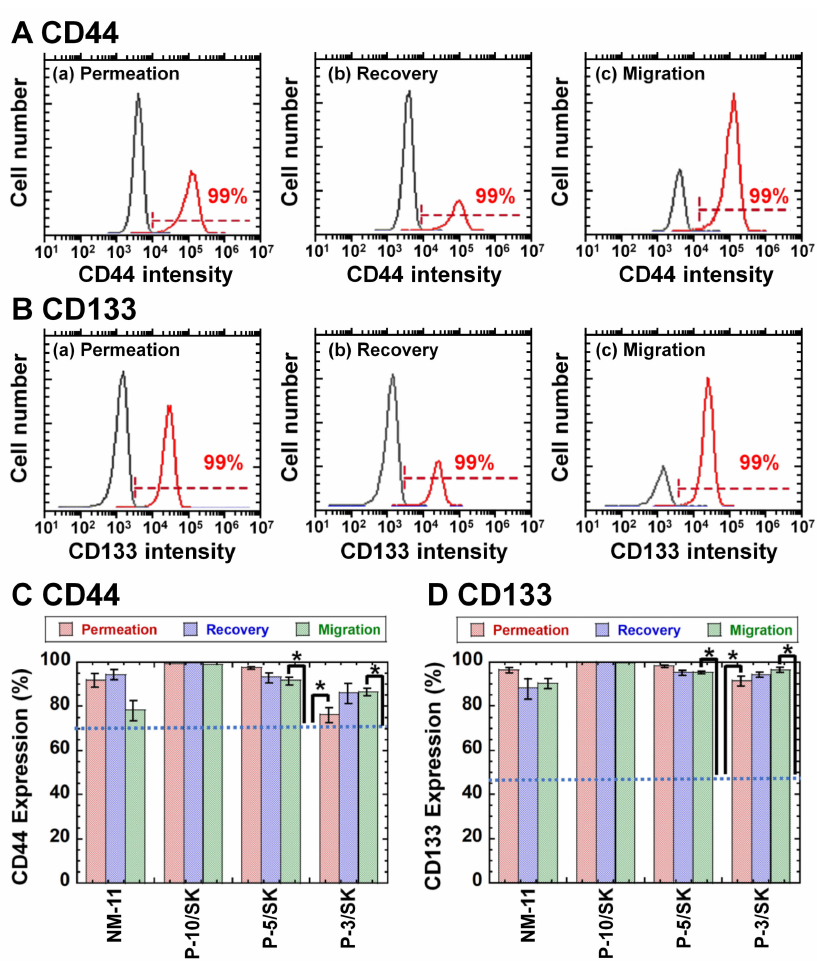
Figure 4. CD44 and CD 133 (CSC marker) expression in colon carcinoma HT-29 cells after filtration via NM-11 and PLGA/SK filters. ( A ) Flow cytometry chart of CD44 expression on HT-29 cells in the permeation solution ( a ), recovered solution ( b ), and migrated cells ( c ) via PLGA-10/SK filters. ( B ) Flow cytometry chart of CD133 expression on HT-29 cells in permeation solution ( a ), recovered solution ( b ), and migrated cells ( c ) via PLGA-10/SK filters. ( C ) CD44 expression on colon carcinoma HT-29 cells in the recovered solution, permeation solution, and cells migrated via NM-11, PLGA- 10/SK (P-10/SK), PLGA-5/SK (P-5/SK), and PLGA-3/SK (P-3/SK) filters. ( D ) CD133 expression on colon carcinoma HT-29 cells in the recovered solution, permeation solution, and cells migrated via NM-11, PLGA-10/SK (P-10/SK), PLGA-5/SK (P-5/SK), and PLGA-3/SK (P-3/SK) filters. The dotted lines indicate CD44 ( C ) and CD133 ( D ) expression on colon carcinoma HT-29 cells incubated on TCP plates. * p <